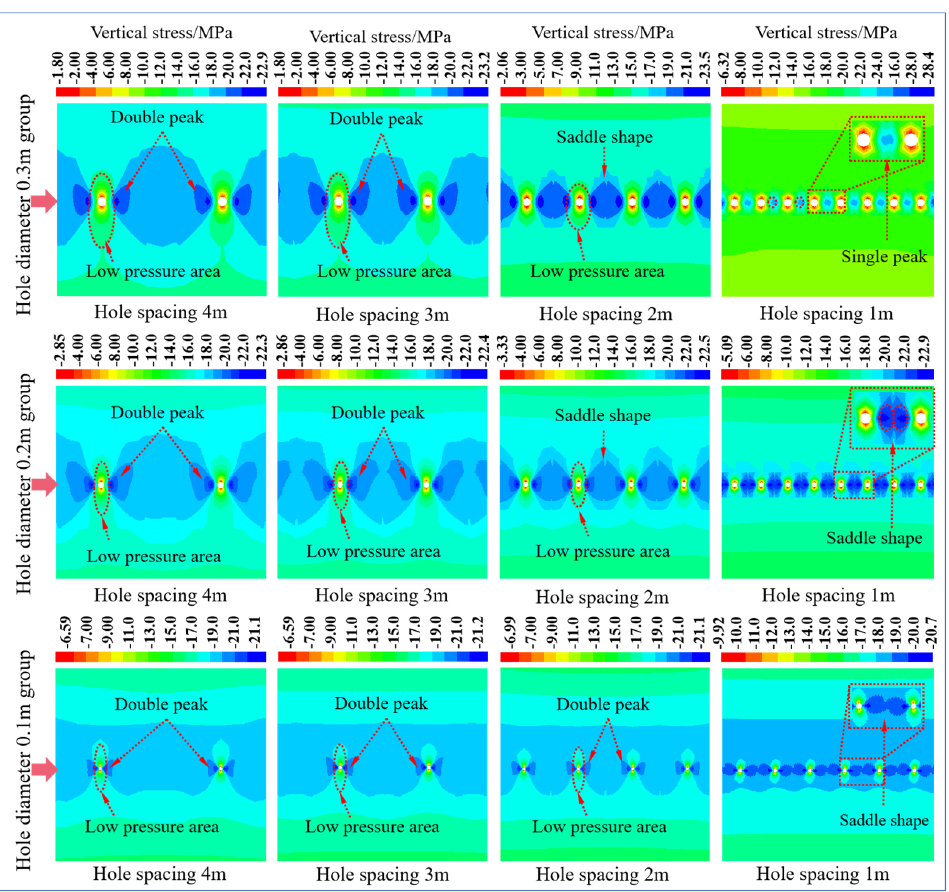
Figure 13. Stress evolution between the boreholes with different hole diameters and hole spacings.